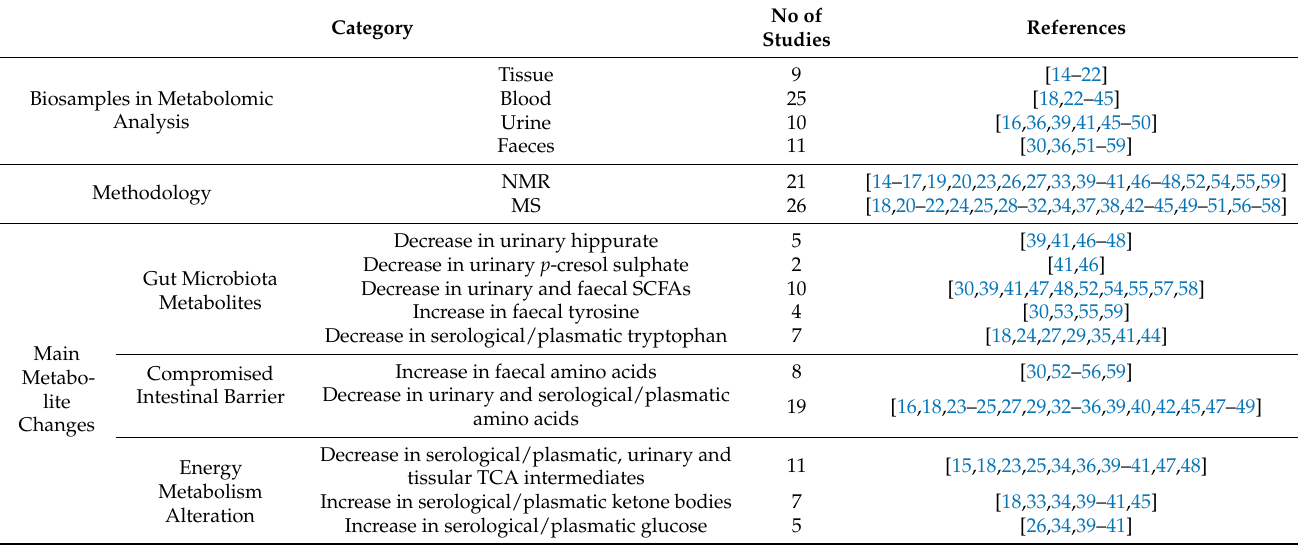
Table 1. Main findings in the IBD metabolome as compared to controls. Category